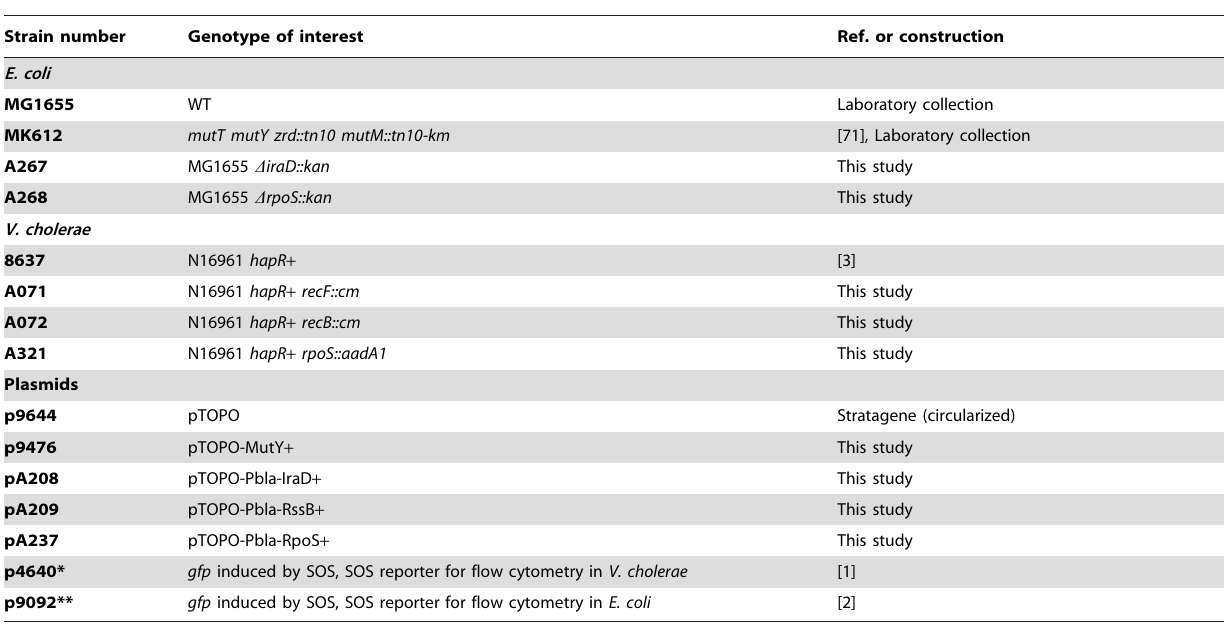
Table 1. Strains and